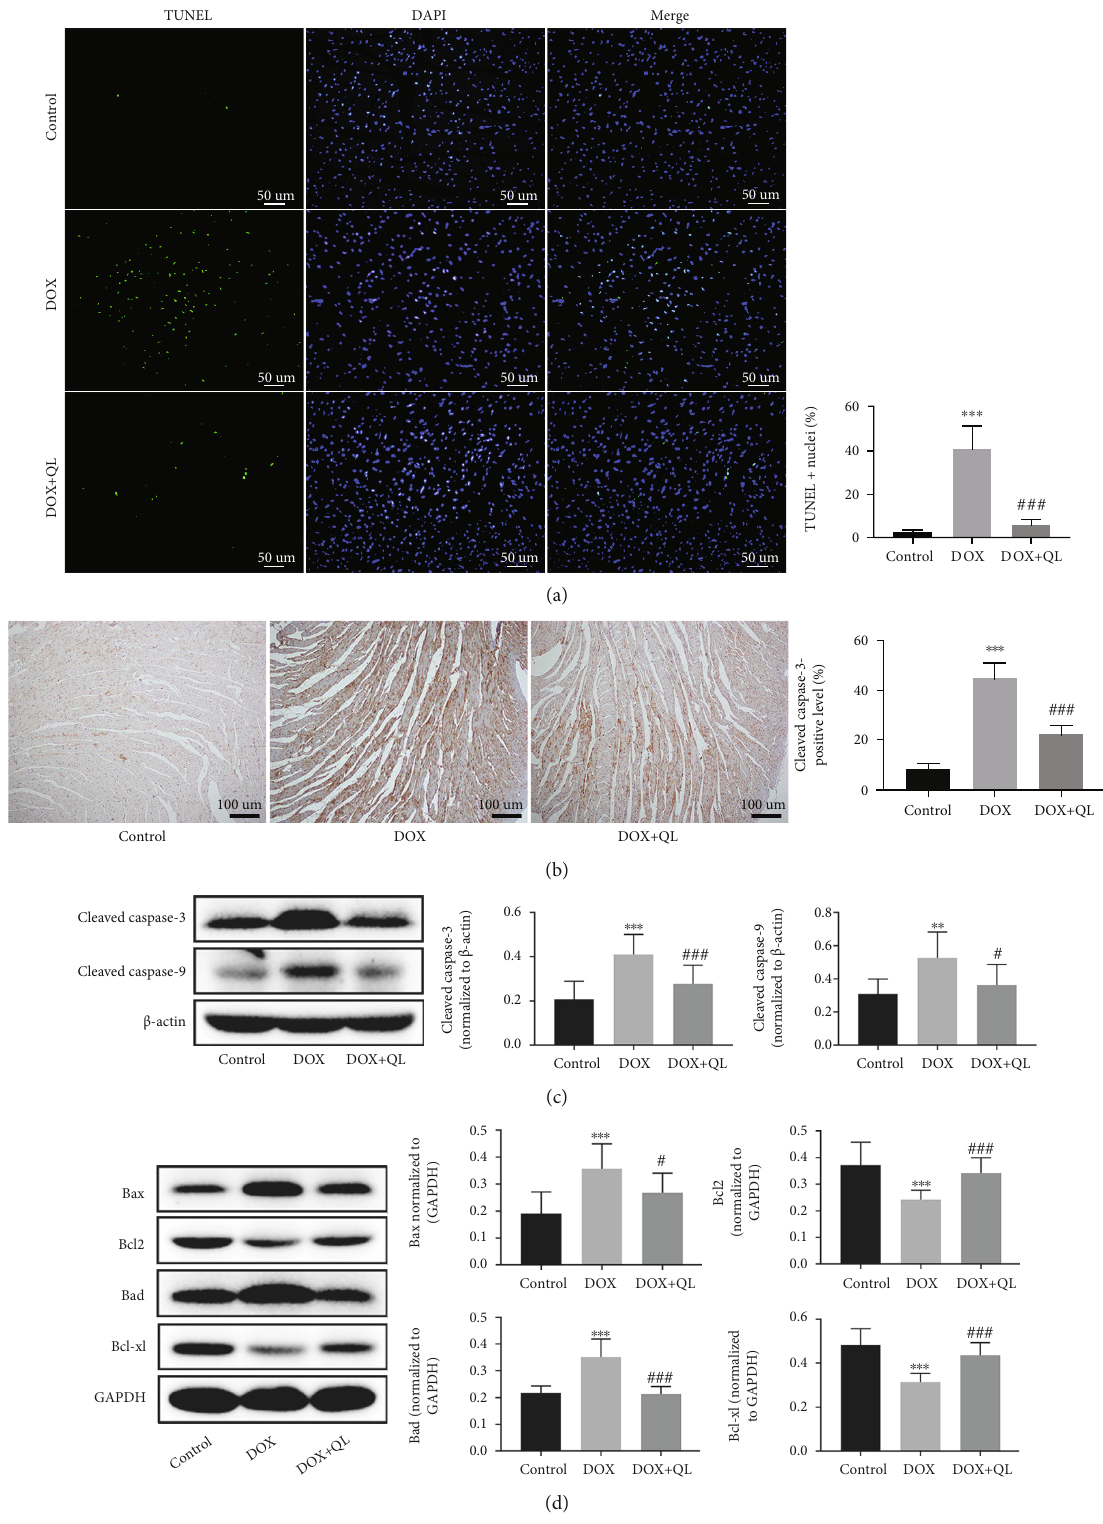
Figure 5: QL inhibited DOX-induced cardiomyocyte apoptosis in ratsunder DOX exposure for 28 days. (a) TUNEL staining of cardiomyocytes in three groups. Positive nuclei were stained in green, and nuclei were stained in blue ( n = 7 per group, 300dpi, scale bar: 50 μ m). (b) Representative immunohistochemical images of cleaved caspase-3 expression in heart tissues in three groups ( n = 4 per group, 300dpi, scale bar: 100 μ m). (c, d) The expression levels of cleaved caspase-3, cleaved caspase-9, Bax, Bcl-2, Bcl-xl, and Bad in di ff erent group heart tissues by western blot ( n = 6 ) (values are presented as mean ± SD ; ∗∗ P < 0 : 01 and ∗∗∗ P < 0 : 001 vs. control group; # P < 0 : 05 , ## P < 0 : 01 , and ### P < 0 : 001 vs. DOX